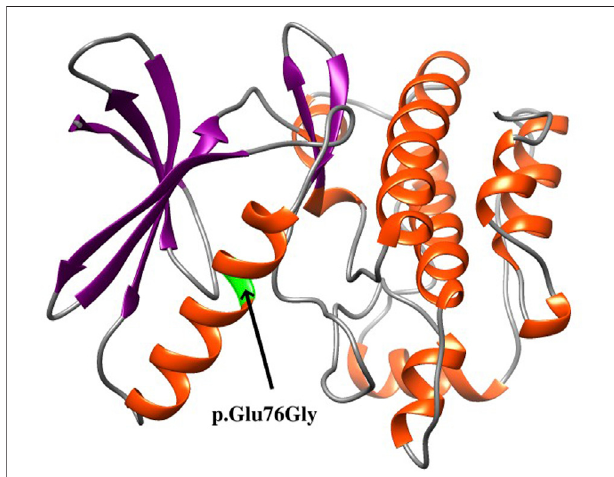
FIGURE 2 | Structure of the kinase domain of the TAOK1 protein from amino acids 28 to 281, showing the localization of the identi fi ed variant